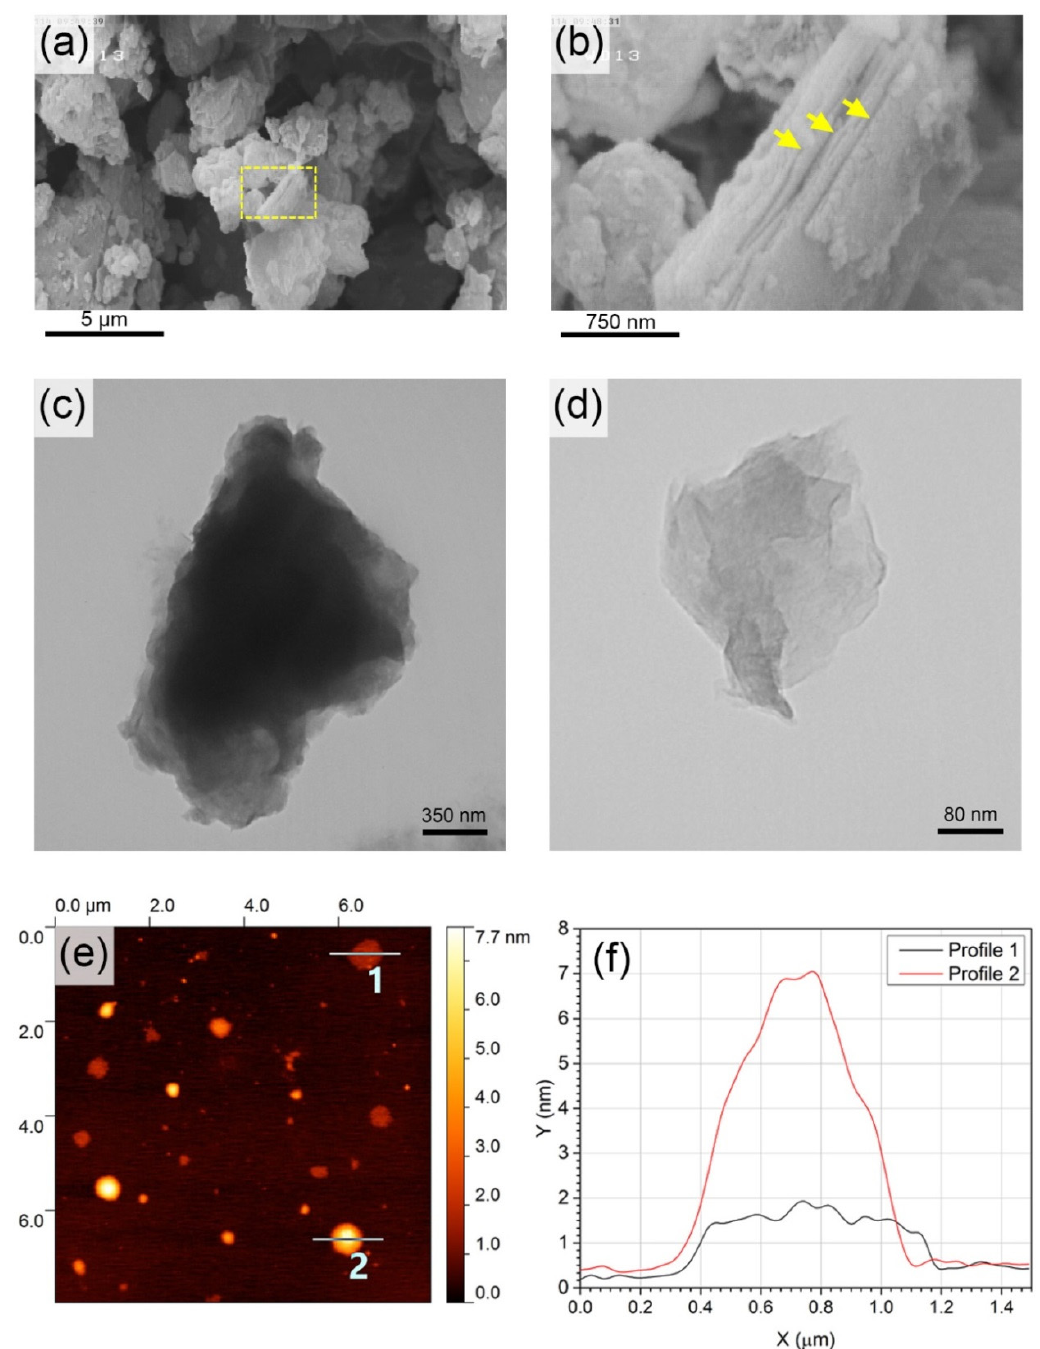
Figure 3. ( a ) FESEM image of the synthesized OMMT powder and ( b ) a higher magnification image from the selected area in ( a ) where arrows denote the lamellar structure of the OMMT particle, TEM micrographs of ( c ) intercalated and ( d ) exfoliated OMMT particles, ( e ) AFM image and ( f ) corresponding line profiles of the synthesized OMMT.